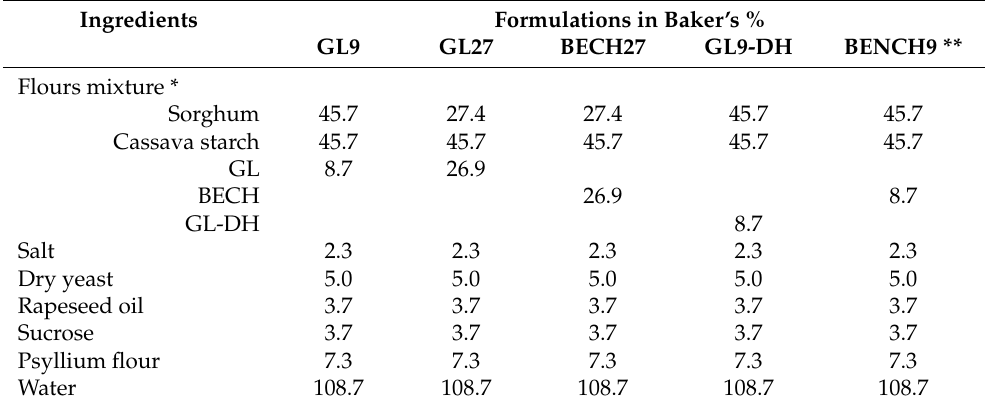
Table 1. Bread dough formulations tested for baking properties and descriptive sensory and for sensory with naive